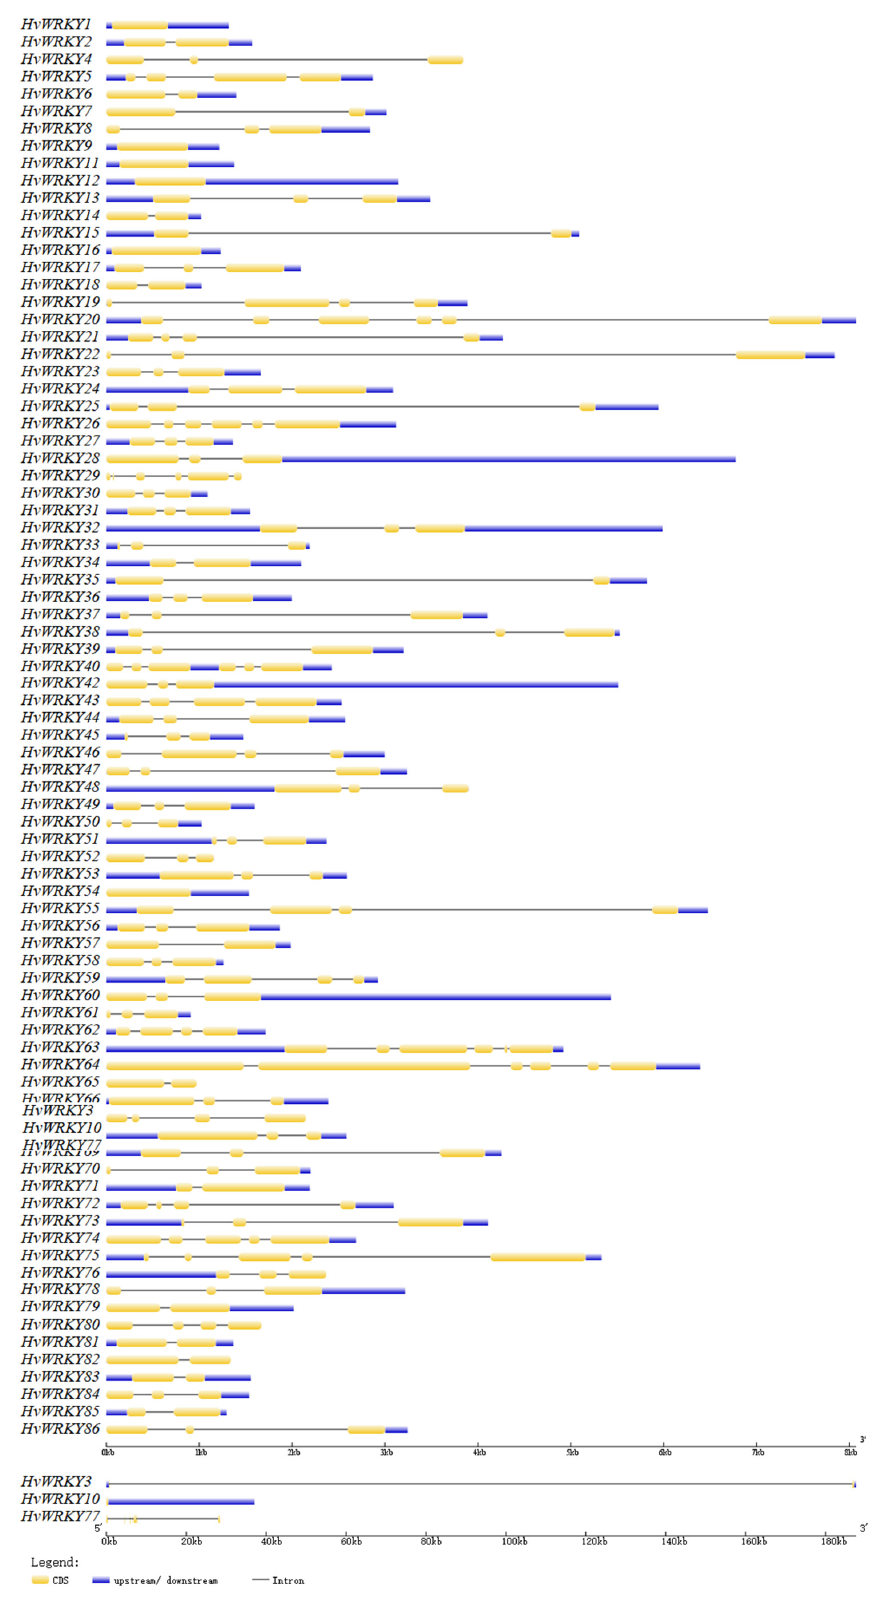
Figure 6. Intron–exon structure of HvWRKY gene. The gene structure of HvWRKY was analyzed by GSDS. The yellow block represents the coding sequence (CDS), the blue block represents the 5’ or 3’ untranslated region (UTR), and the black line represents intron. Three genes ( HvWRKY3 , HvWRKY10 , HvWRKY77 ) are displayed on a smaller